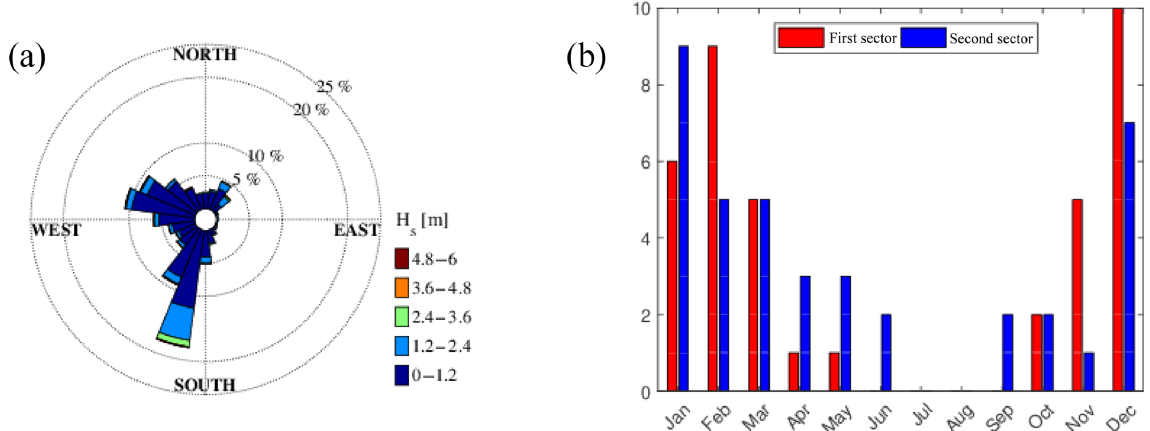
Figure 6. (a) Rose of significant wave height for hindcast Point_002550; (b) seasonal distribution of the annual maxima wave height due to the considered sectors.